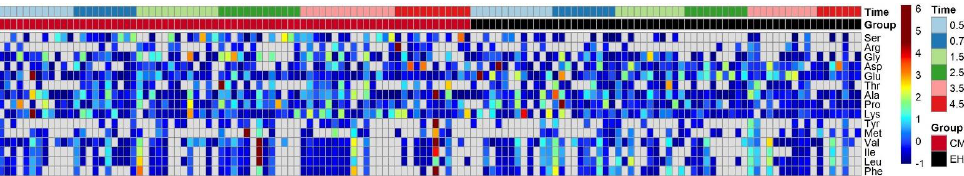
Figure 6. Heatmap of fecal amino acid concentrations (standardized by mean and standard deviation per amino acid) from 0.5 to 4.5 months in CMF (cow milk formula; red bar) and EHF (extensive protein hydrolysate formula; black bar) groups. Red signifies higher abundance. No significant group or group × time effect for any of the amino acids identified; linear mixed-effects model. 3.4. Increases in the Relative Abundance of Clostridia Related to Leaner Phenotypes While no measured infant phenotypes differed at baseline (Table 1), the two random- ized groups significantly differed in subsequent velocities of weight gain from 0.5 to 4.5 months, in fat mass and percent body fat at 3.5 months, and in WLZ scores at 4.5 months, but did not differ in velocities of linear growth (Table 2). The two groups also significantly